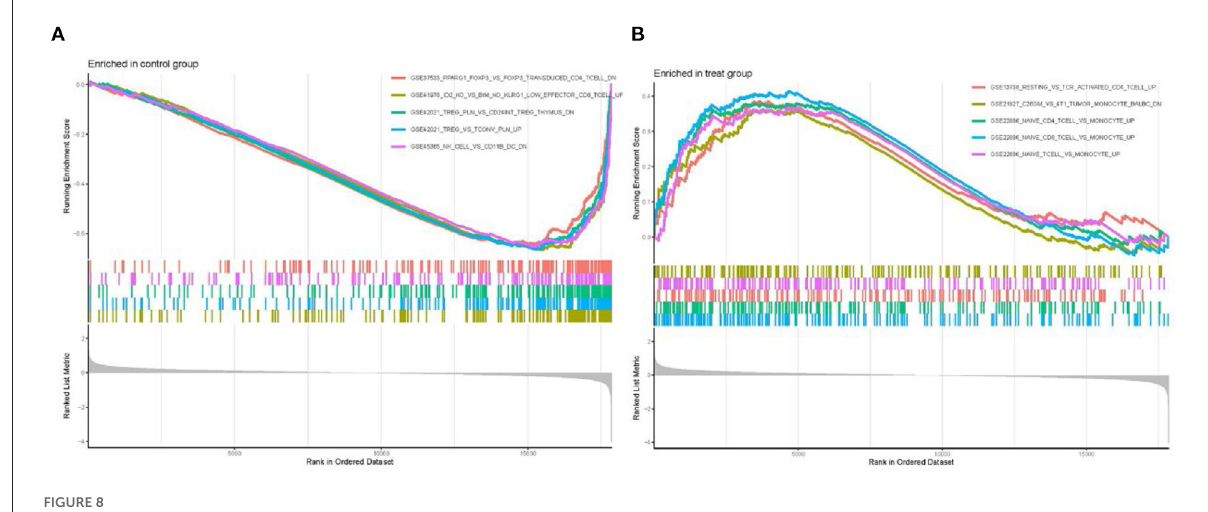
FIGURE8 Enrichment of GSEA immune signature gene set. (A) Immune gene set scores in the control group. (B) Immune gene set scores in the cardiomyopathy